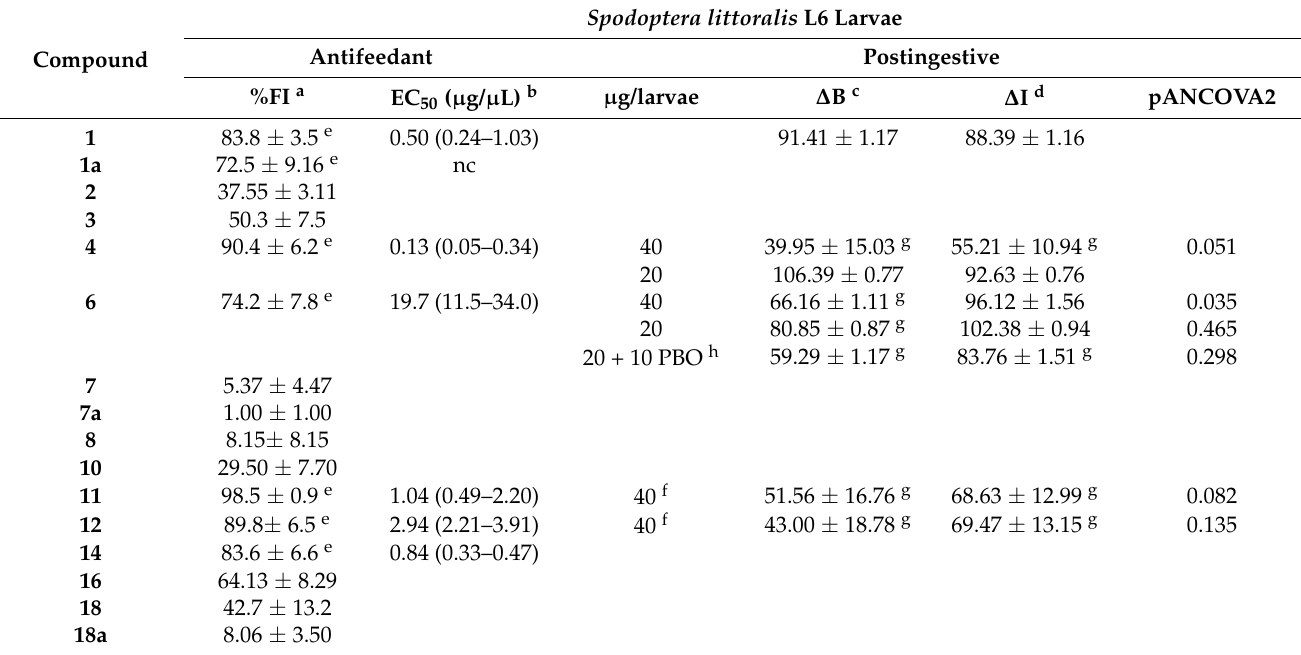
Table 4. Insect antifeedant and postingestive effects of compounds 1–8 , 10–12 , 14 , 16 , 18, and 18a